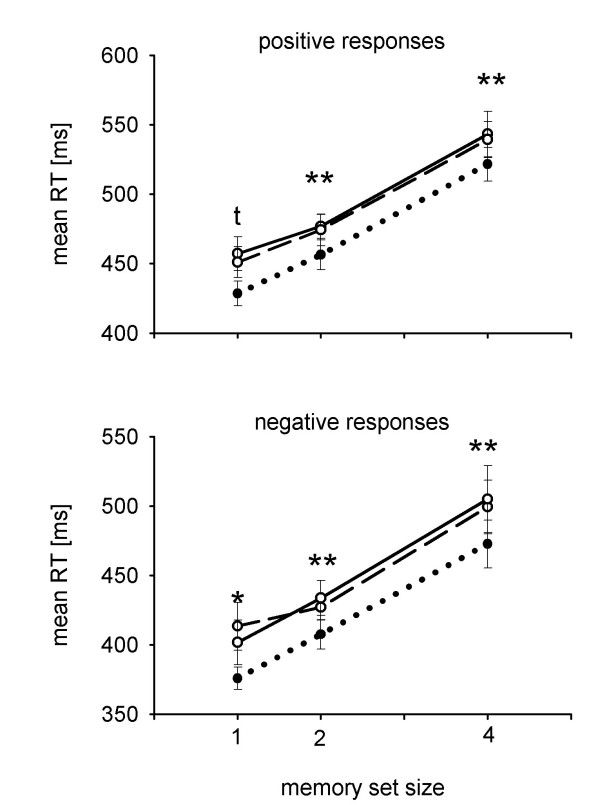
Relation between mean reaction time and size of memory set. Positive (top) and negative responses (bottom) are depicted during placebo (dotted line), anodal (continuous line) and cathodal (dashed line) tDCS stimulation (n = 12). For post-hoc t Tests data of both stimulation sessions were collapsed since they were practically identical (see text). Symbols indicate differences in reaction time between placebo and stimulation. ** p < 0.01, * p < 0.05, t p < 0.1.